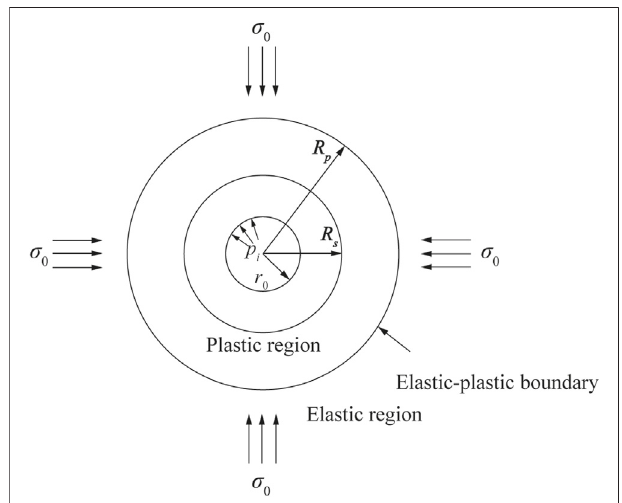
FIGURE 1 | Mechanical model for a circular tunnel in strain-softening rock